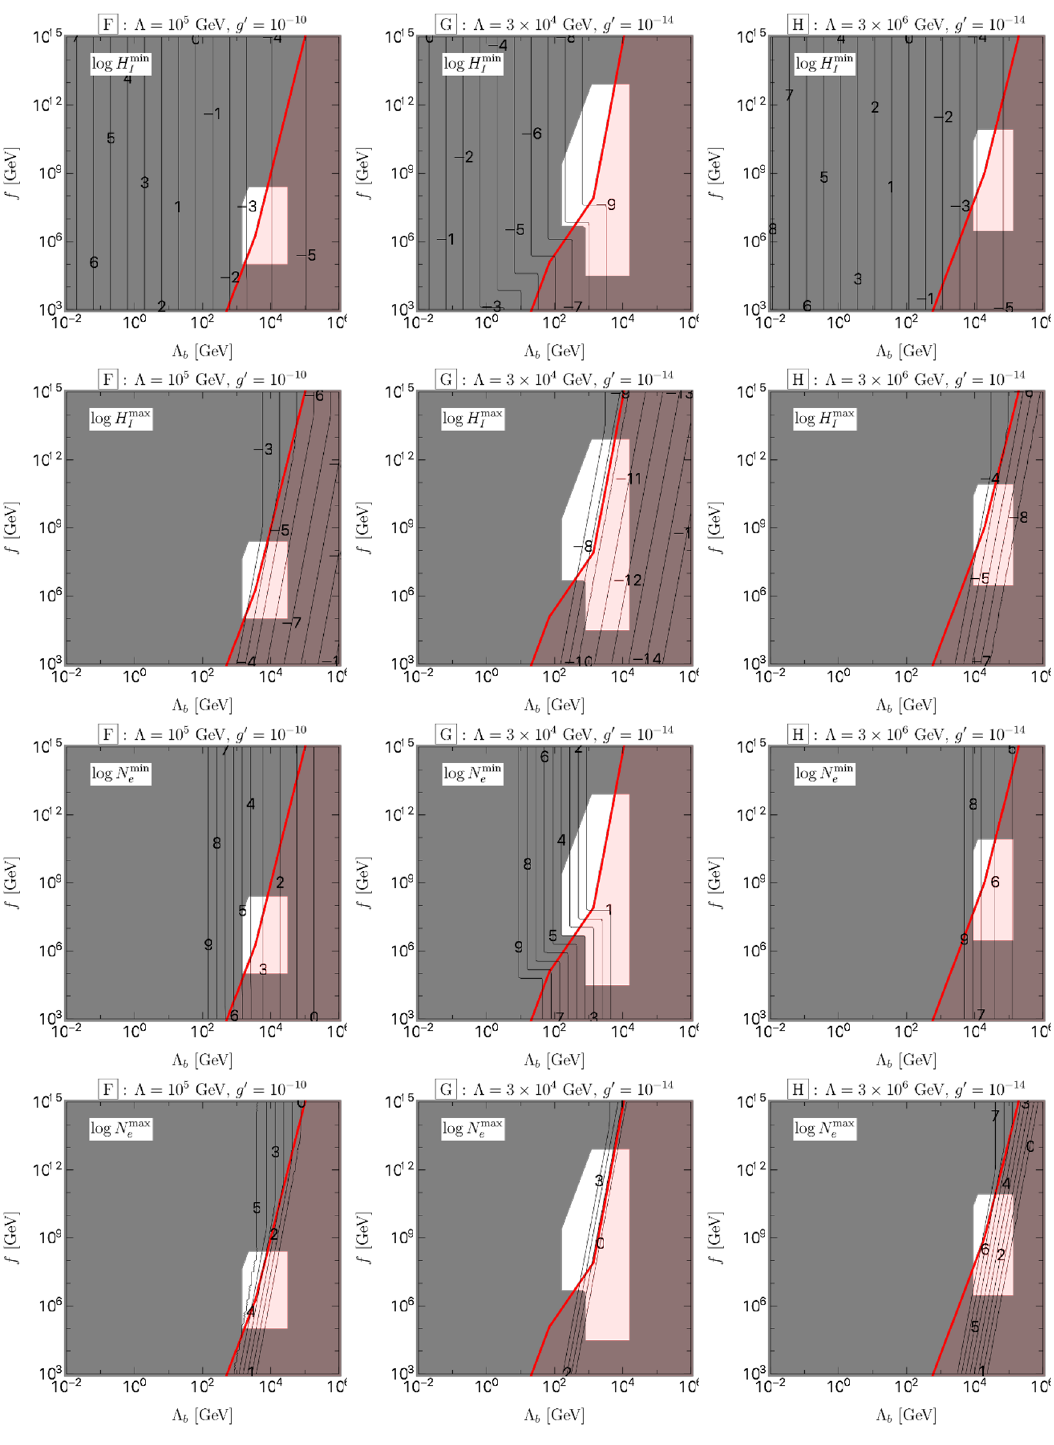
Figure 3 . Same as in figure 34 of the paper. In the scenario with EW gauge boson production during inflation described in section 4.2, we highlight the contours for the minimal and maximal value of the Hubble rate H I (in GeV) and of the number of efolds of inflation that relaxation takes to complete, for each benchmark point F , G , H